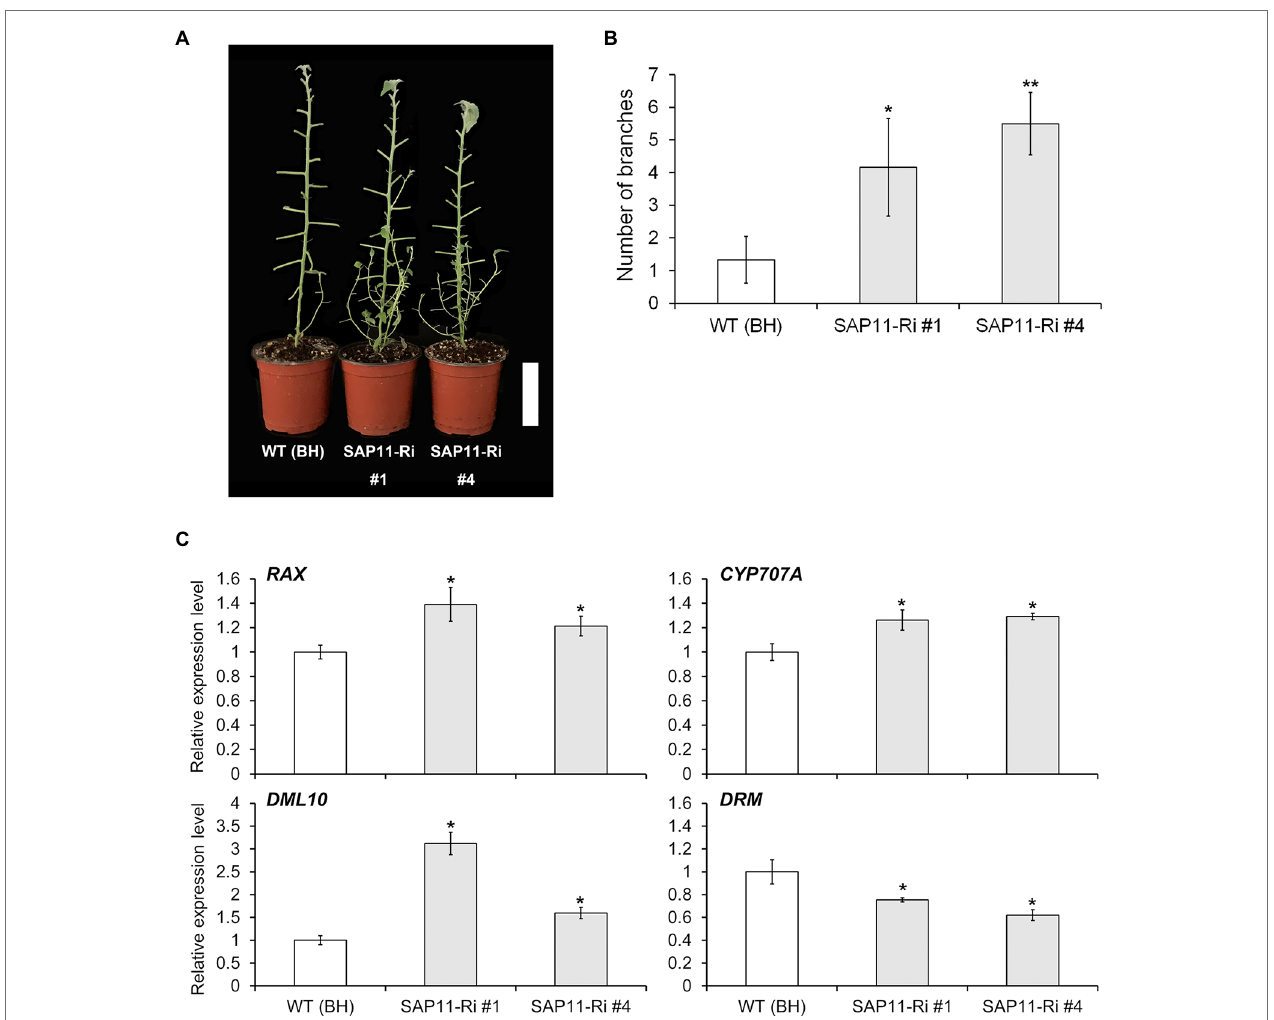
FIGURE 5 | PagSAP11 -RNAi hybrid poplars exhibit increased sylleptic branching. (A) Sylleptic branching in representative defoliated WT (clone BH) and transgenic poplars. (B) Sylleptic branch number in WT and transgenic poplars grown for 2 months on the soil after acclimation ( n = 5). (C) Relative expression levels of genes involved in bud outgrowth. The values represent the means ± standard deviations (SDs) of three biological replicates. Asterisks indicate significant differences by student t -test (* p < 0.05, ** p < 0.005). Scale bar = 10